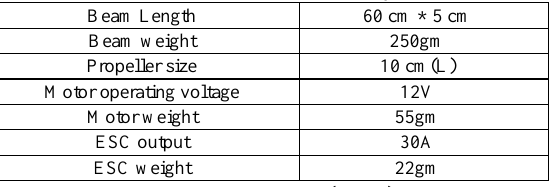
Table 1: Parameters of the system.